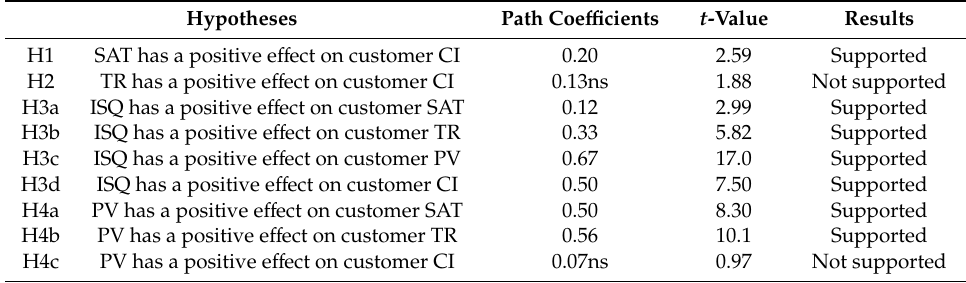
Figure 2. The results of the relationship quality model. Note: ** p < 0.01 = t > 2.58; *** p < 0.001 = t > 3.29; with a two-tailed test. ns = not supported. Table 6. Summary the results of the